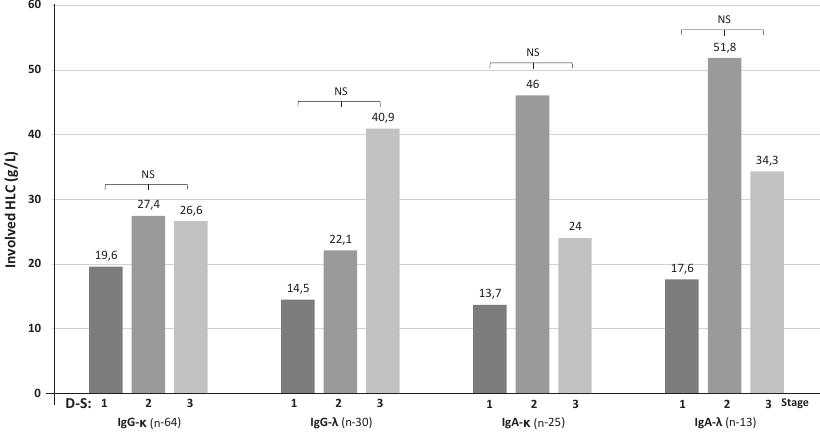
Fig. 2. Comparison of medians of serum levels of involved HLC to stages 1-3 of multiple myeloma assessed using Durie-Salmon stratification system (D-S) with regard to κ and λ types in the group of IgG and IgA multiple myeloma patients.